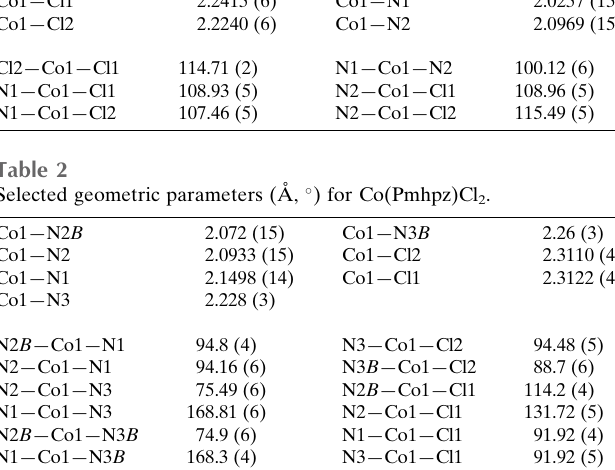
Table 1 Selected geometric parameters (A˚ , (cid:5) ) for Co 2 (Ppz)Cl 4 . Co1—Cl1